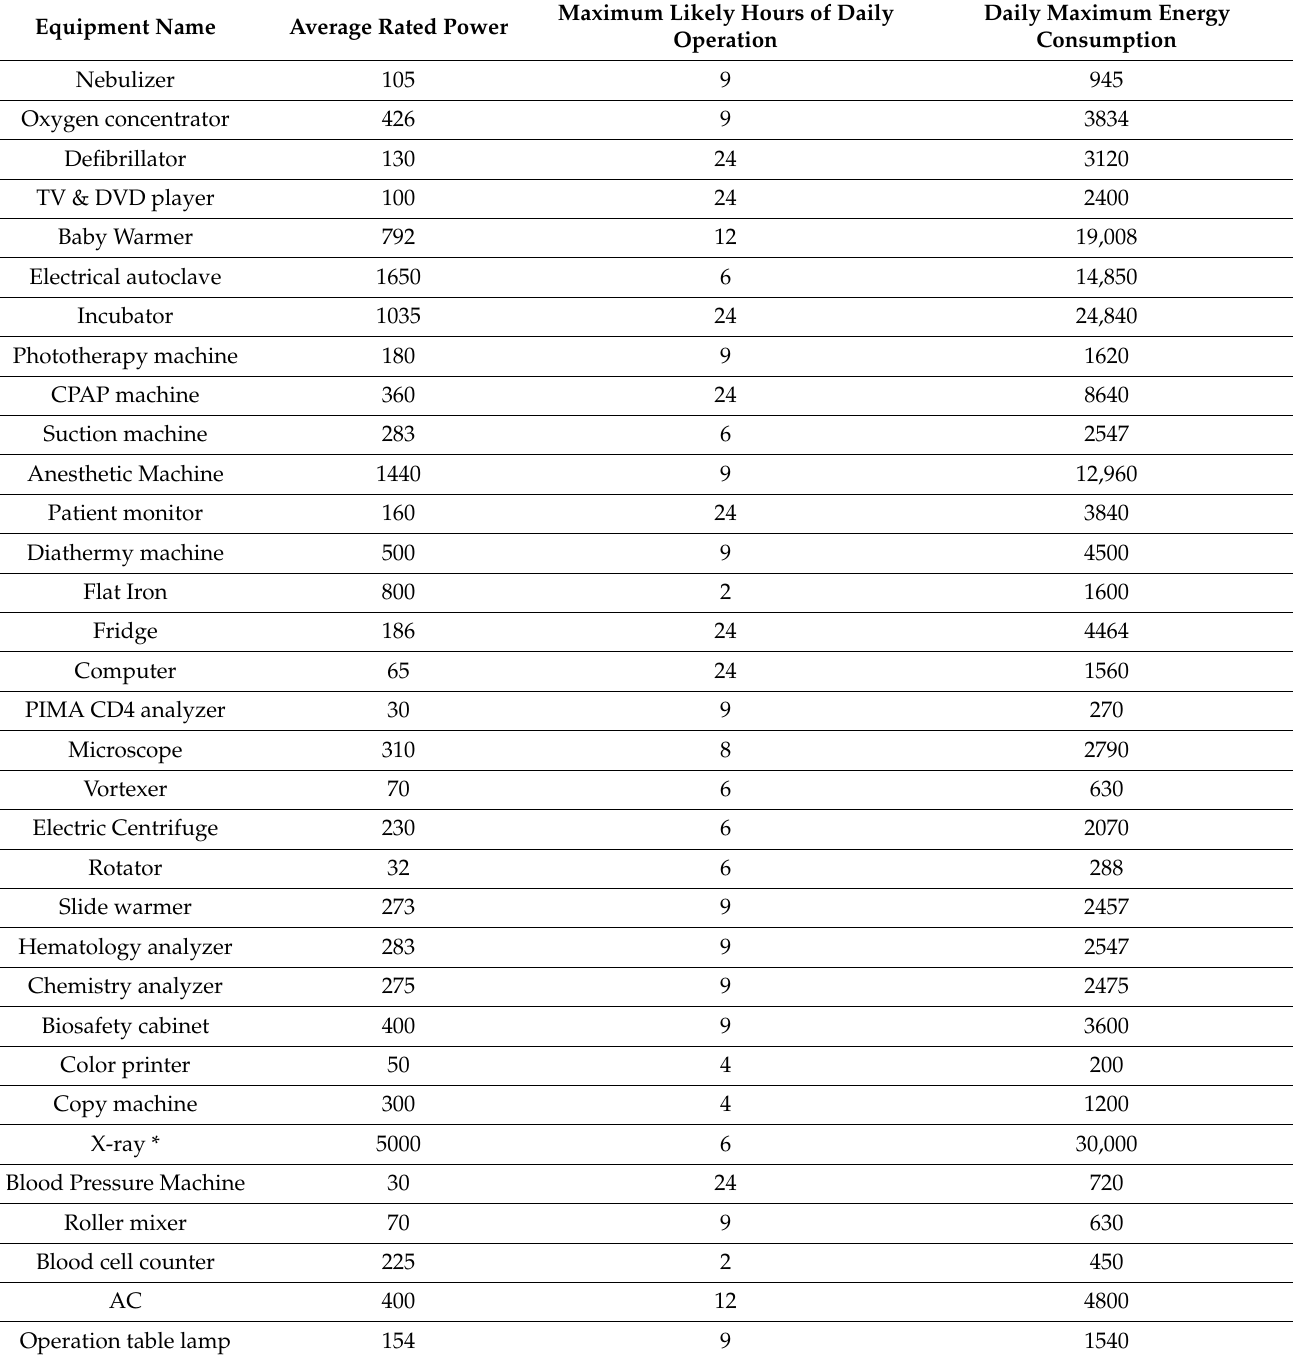
Table A1. Rated power and maximum hours of use for major equipment applicable in district-based healthcare